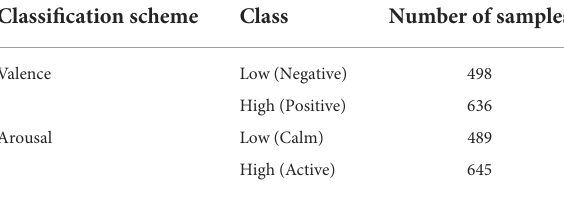
TABLE 1 Number of samples for each class of